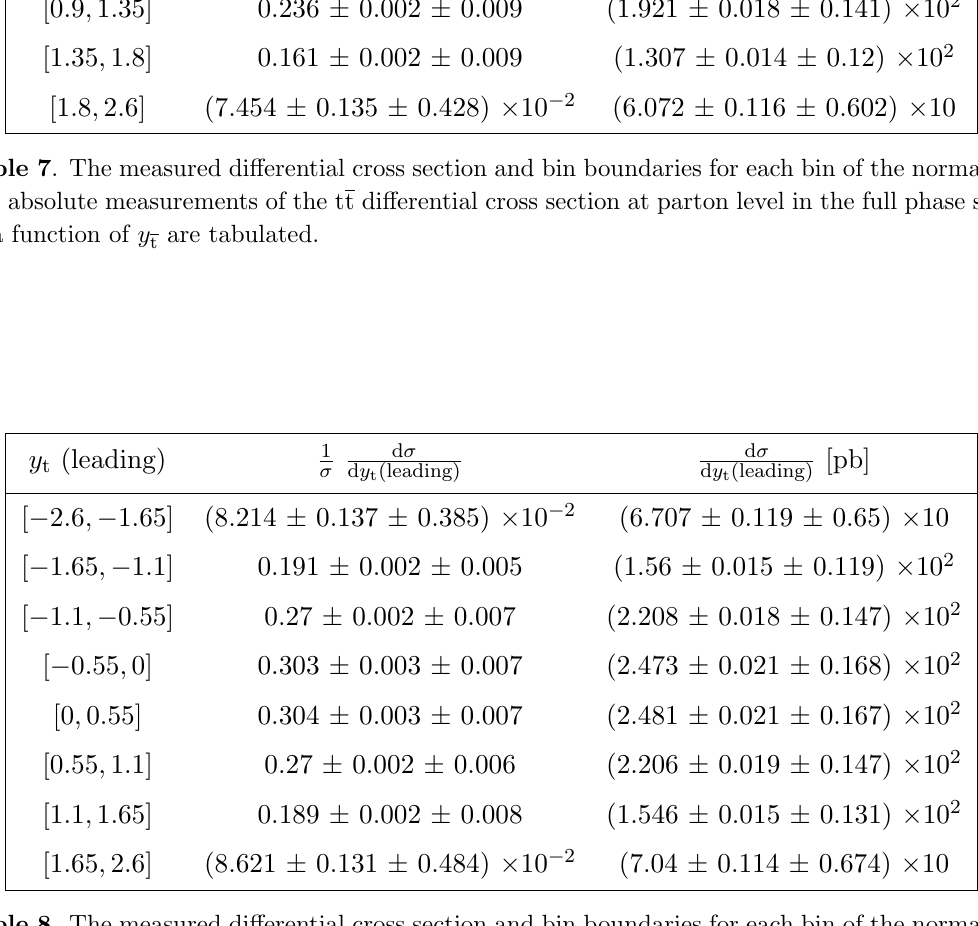
Table 8 . The measured di(cid:11)erential cross section and bin boundaries for each bin of the normalized and absolute measurements of the tt di(cid:11)erential cross section at parton level in the full phase space as a function of y t (leading) are